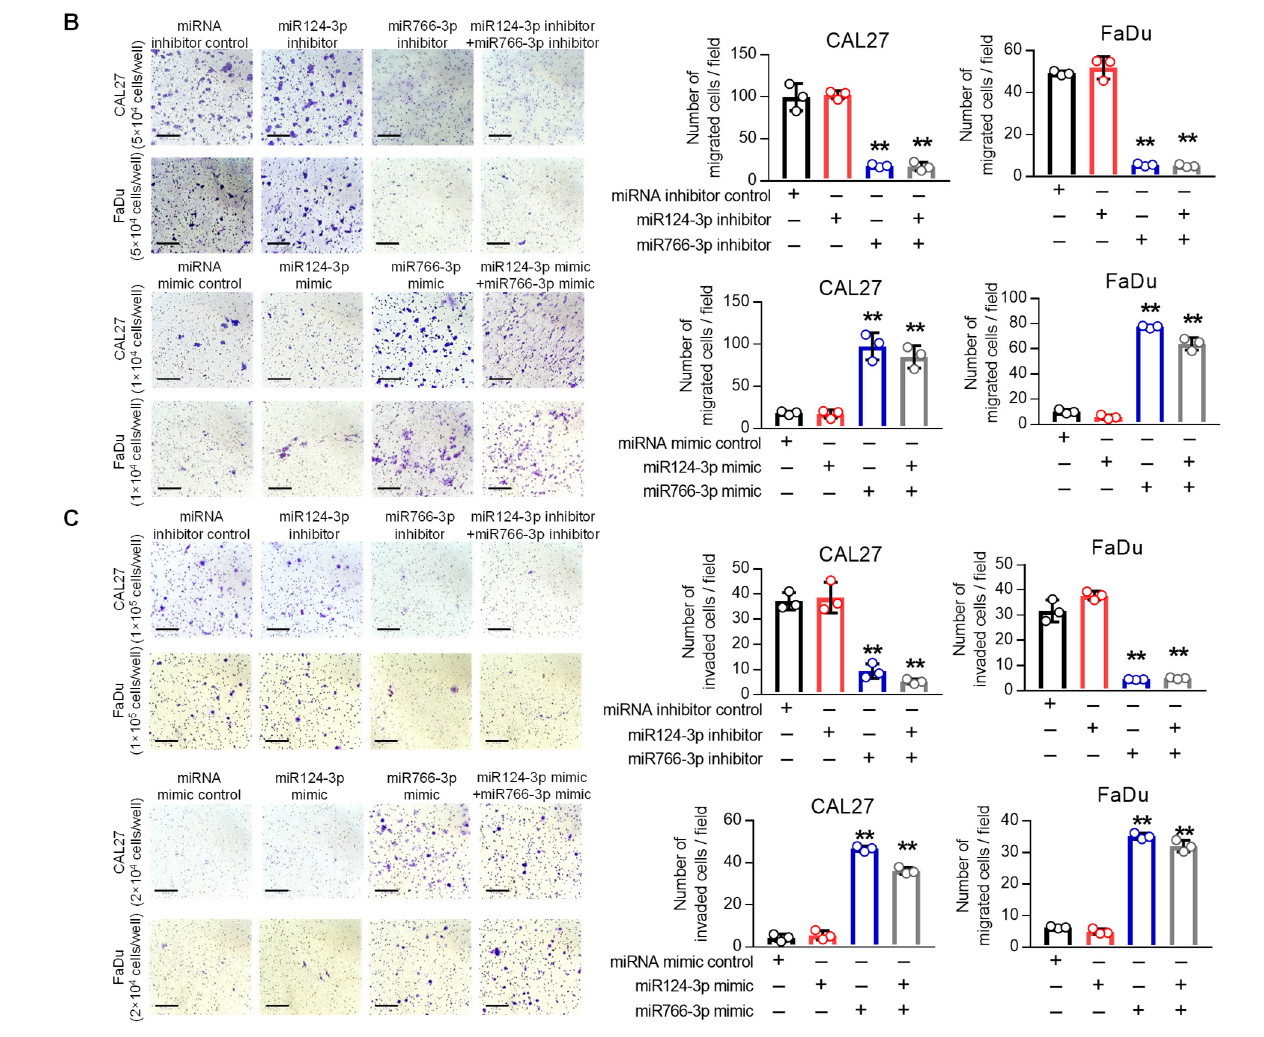
Figure 4. The effect of miR766-3p and miR124-3p expression on HNSCC cell motility. ( A ) Mea- surement of cell migration by scratch wound healing assay in CAL27 and FaDu cells following transfection with 10 nM miRNA inhibitors (left) or miRNA mimics (right). The images were taken at 0 and 24 h after scratching the confluent cell monolayer with micropipette tip (scale bar, 520 µ m). The length of the gap was measured for each sample and presented as the average ratio of residual gap to the initial gap in graphs. ( B , C ) Determination of cell migration and invasion by transwell assay. Following transfection with either miRNA inhibitors (top) or mimics (bottom), cells were seeded on the upper chamber of a transwell insert, and cell migration to the lower chamber ( B ) or invasion in Matrigel ( C ) was determined as described in methods. The migrated or invaded cells are presented as average number per field in triplicate (Scale bar, 210 µ m). A one-way ANOVA with Bonferroni’s correction for multiple comparisons was used to analyze group comparisons, and data are presented as means ± SD (n = 3). * p < 0.05 and ** p <